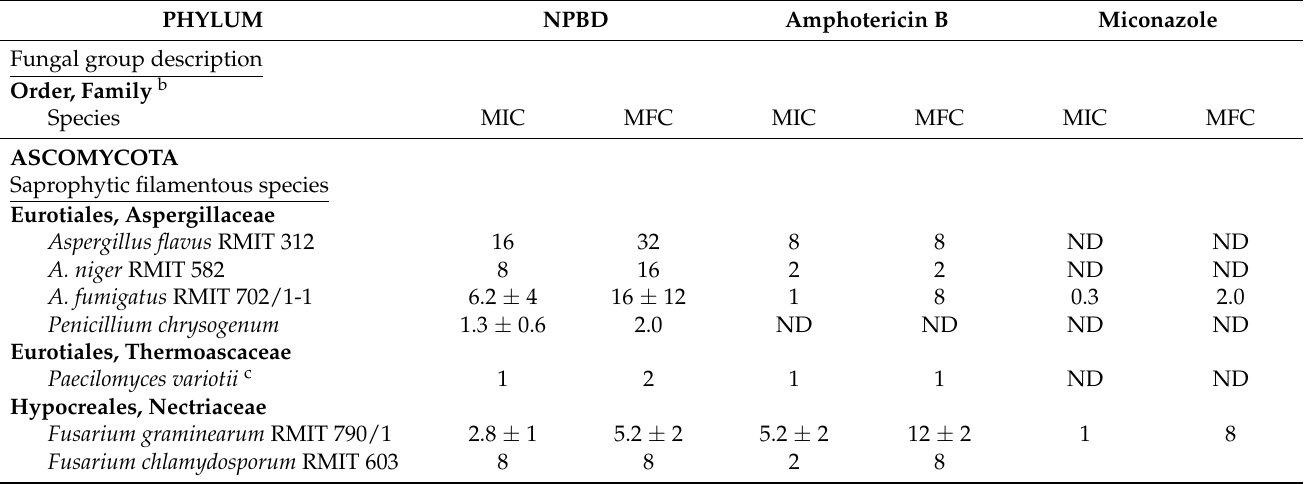
Table 1. Antifungal activity (MIC and MFC) a of NPBD, Amphotericin B and